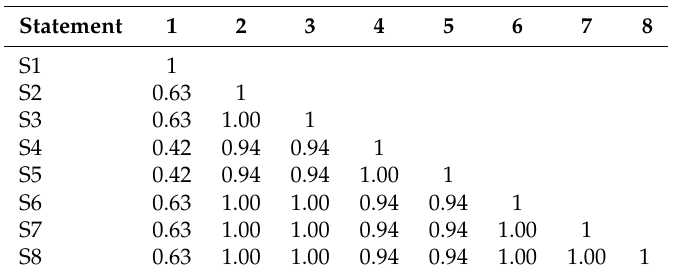
Table 7. CPUS statement